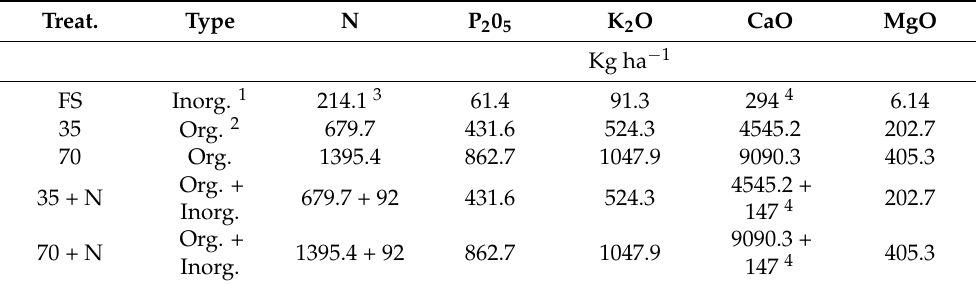
Table 3. Total amounts of nutrients added in each treatment.